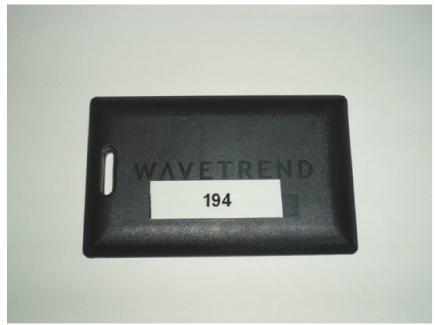
Figure 12: An identification card.